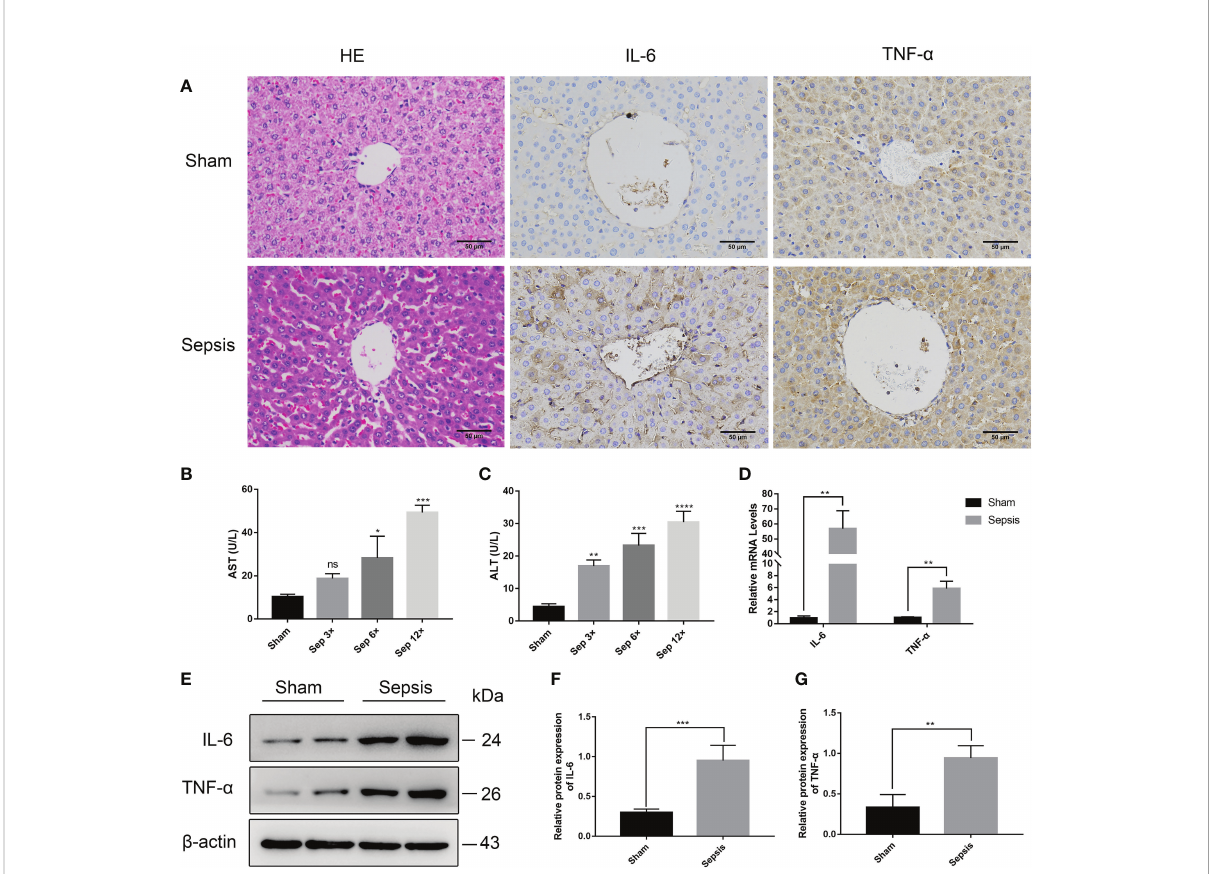
FIGURE 5 Liver injury in the rat model of urinary sepsis (A) Representative images of hematoxylin and eosin (H&E) staining of liver tissue from the sham and sepsis groups, immunohistochemical analysis of IL-6 and TNF- a in liver tissue (magni fi cation, 200×; bar). (B, C) Serum AST and ALT levels in rats 24 hours after E. coli or saline inoculation of the renal pelvis. (D) The relative mRNA levels of IL-6 and TNF- a in the lung tissue. (E) Expressions of IL-6 and TNF- a in liver tissue were tested by western blot, and b -actin was used as a loading control. (F, G) Quantitative data of the levels of IL-6 and TNF- a . The sep 6× group was selected as a representative of the sepsis groups. Values were shown as mean±SD. *P < 0.05, **P < 0.01, ***P <0.001, and ****P < 0.0001 vs sham group. "ns" means "not